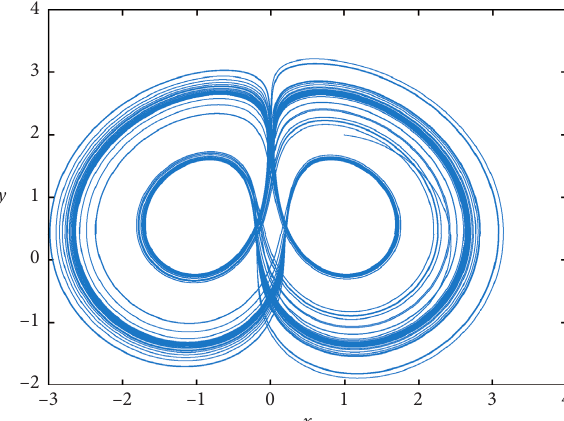
Figure 3: Dynamic behavior of fractional financial chaotic model with α � 0 . 95.